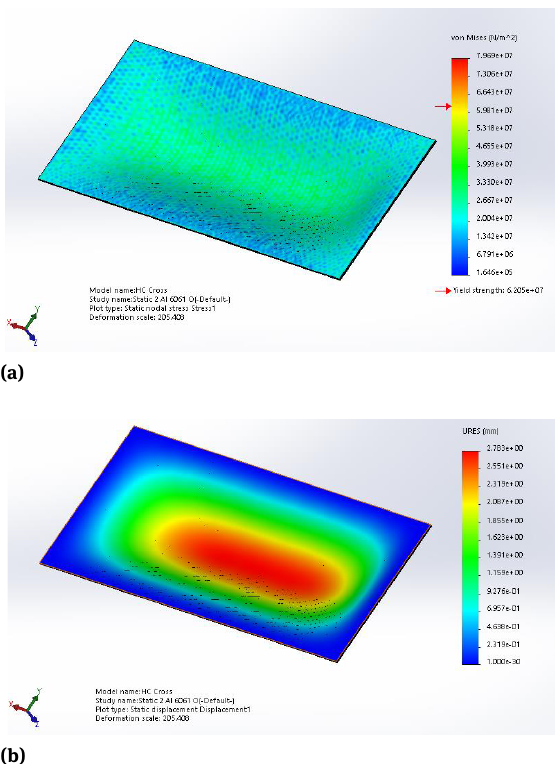
Figure 14: Displacement of the cross honeycomb in the static simu- lation: (a) x-axis, (b) y-axis, and (c)